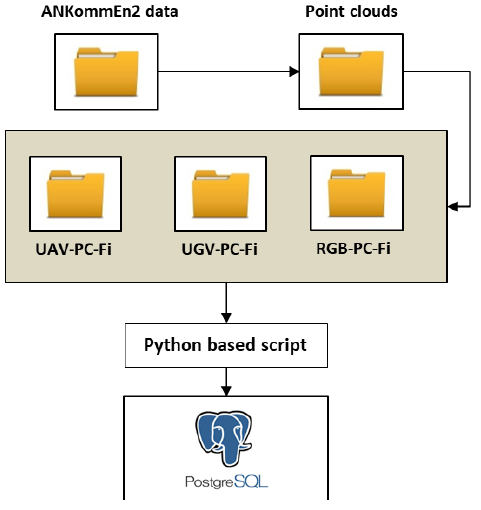
Figure 16: Storage process of point clouds in Postgres/PostGIS